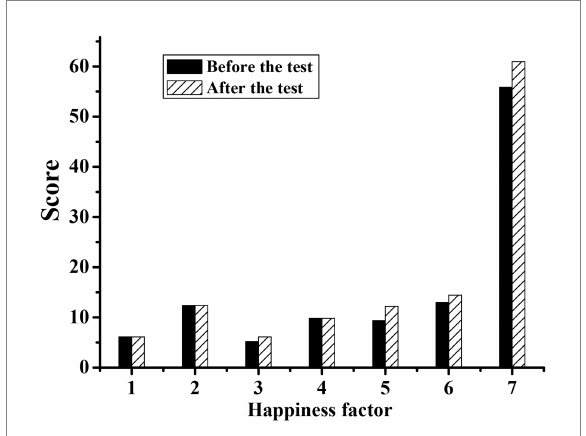
FIGURE 6 Comparison of the scores of the silver-haired happiness scale in the control group before and after the experiment. (1: worry about health; 2: energy; 3: satisfaction and interest in life; 4: depressed or happy mood; 5: control of emotion and behavior; 6: anxiety; 7: total